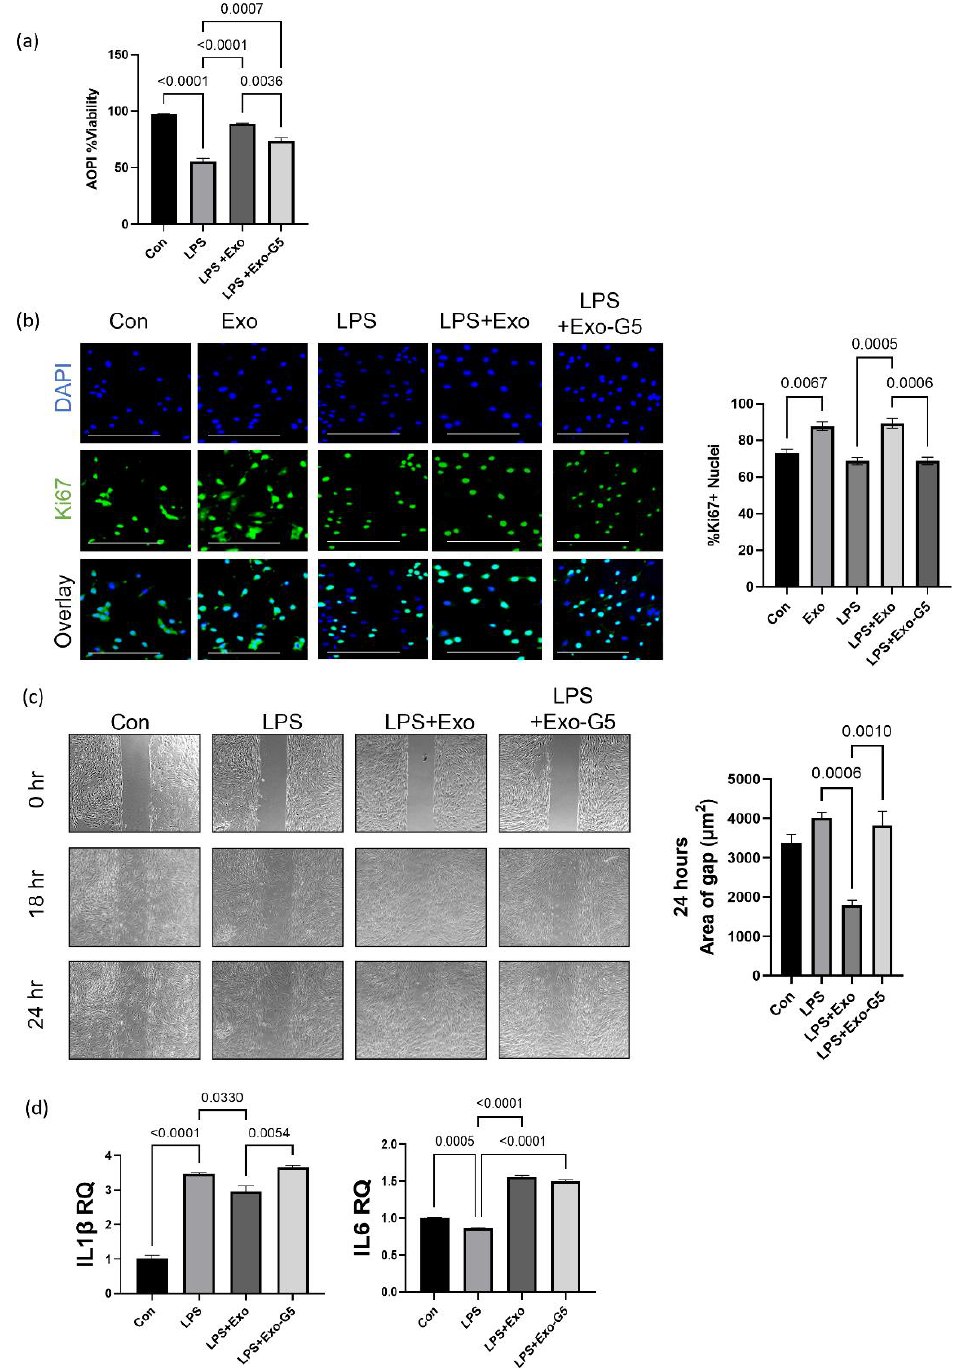
Figure 3. HDF cells were treated with 5 ng/mL LPS for 6 h and the medium was changed, followed by treatment with 1 μ g hASC exosomes (Exo) or exosomes depleted of GAS5 (Exo-G5) for 18 h. ( a ) Acridine orange (AO) and propidium iodide (PI) dual staining was used to determine the viability of HDF cells ( n = 3). Statistical analysis was performed by one-way ANOVA and significant p -values (<0.05) are indicated on the graphs. ( b ) Immunocytochemistry was performed using Ki67 staining as a marker for cellular proliferation in HDF cells. Cells were also stained with nuclear marker DAPI and imaged with a Keyence BZx-810 microscope (scale bar = 200 µm). Colocalization of Ki67 was determined using Keyence software ( n = 3). Statistical analysis was performed by one-way ANOVA